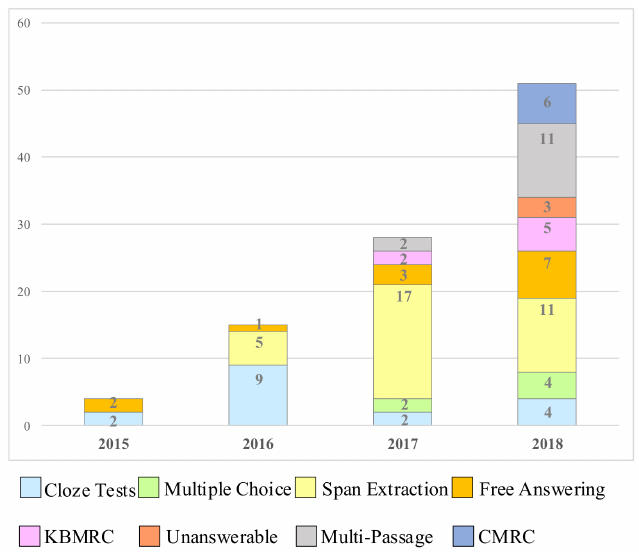
Figure 2. The number of research articles concerned with neural MRC in this survey. KBMRC: knowledge- based machine reading comprehension; CMRC: conversational machine reading comprehension.